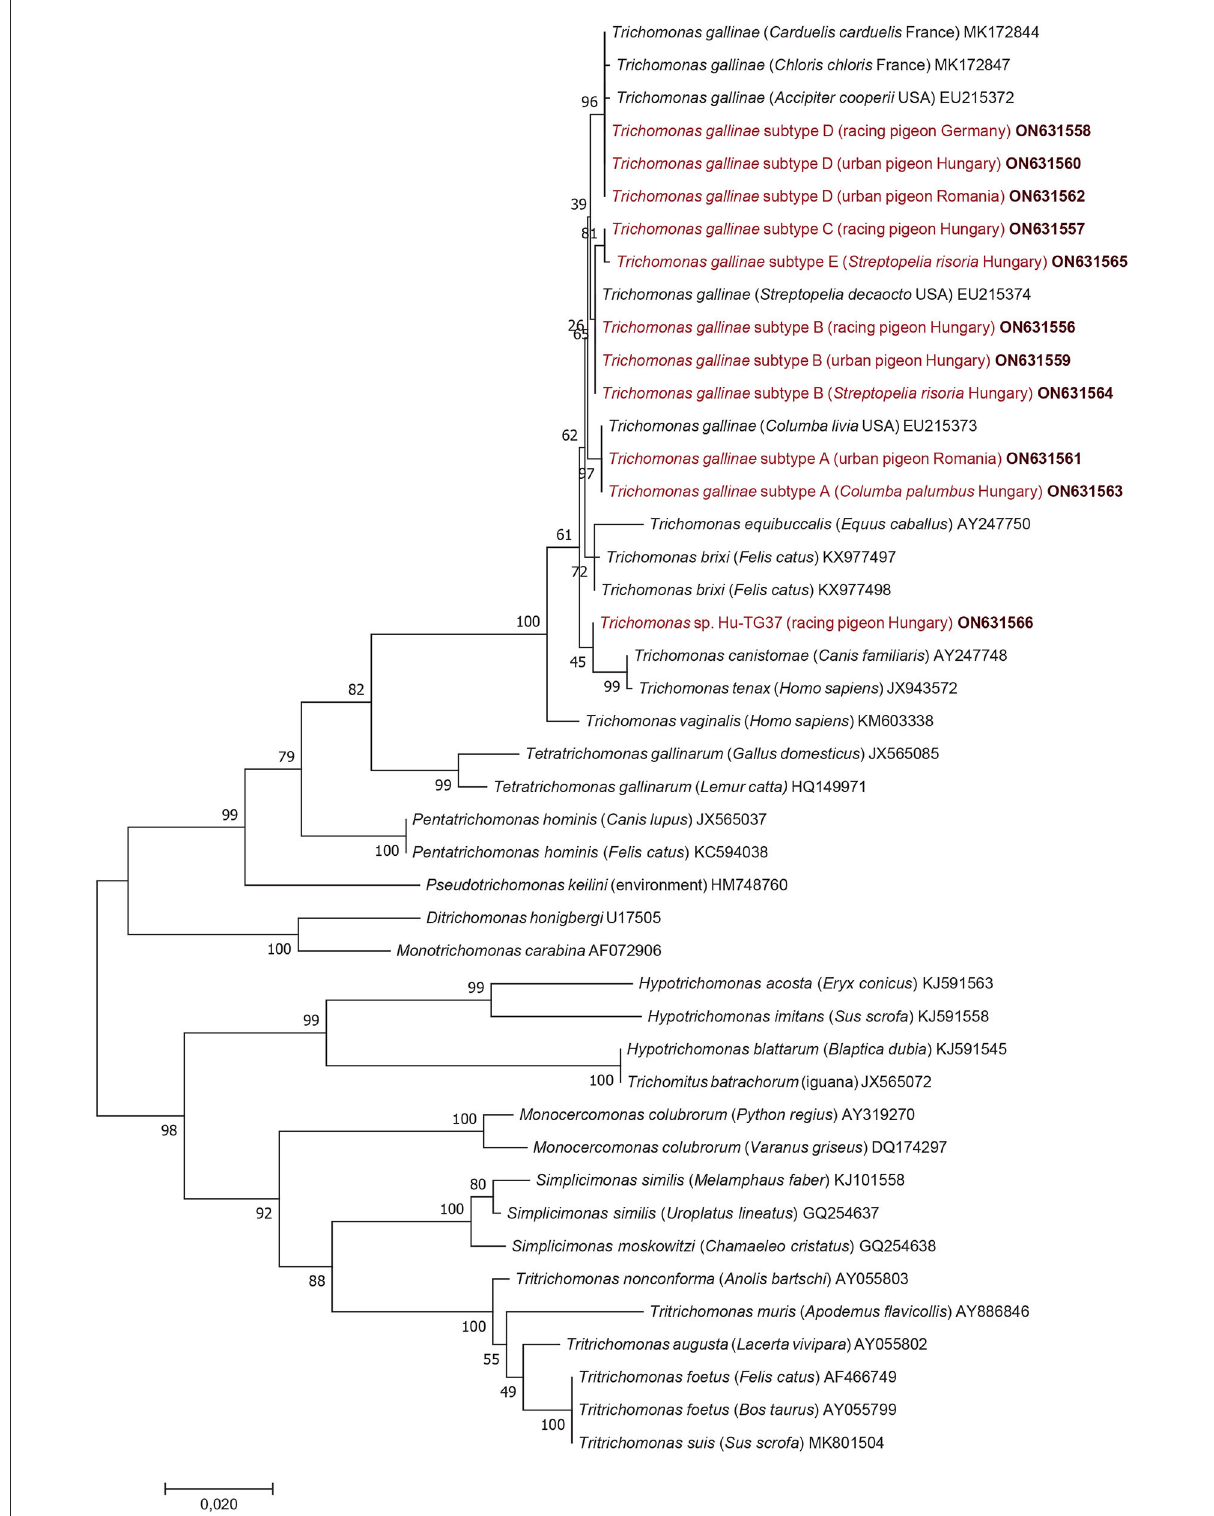
FIGURE1 Phylogenetic tree of Trichomonadea based on the 18S rRNA gene, made with the maximum likelihood method and the Jukes-Cantor model. In each row, after the species or genus name, the isolation source, for Trichomonas gallinae the country of origin and the GenBank accession number are shown. Sequences obtained in this study and representing each subtype are in red and bold accession numbers. The analysis involved 44 nucleotide sequences and 1,000 bootstrap replications. There were a total of 1,121 positions in the final dataset. The scale-bar indicates the number of substitutions per